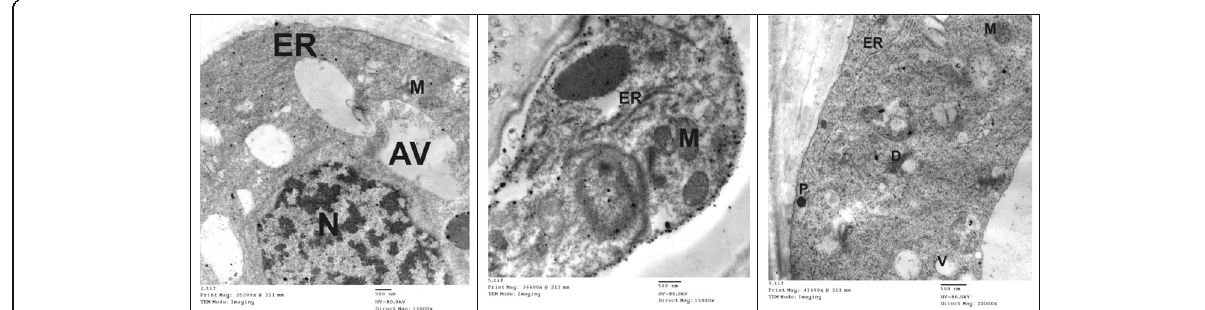
Fig. 2 Ultra-thin section in Allium cepa root tip meristems as control. The normal cell organelles: nucleus (N), mitochondria (M), dictyosomes (D), peroxisomes (P), and endoplasmic reticulum (ER) in addition to vacuole (V) and autophagic vacuoles (AV)